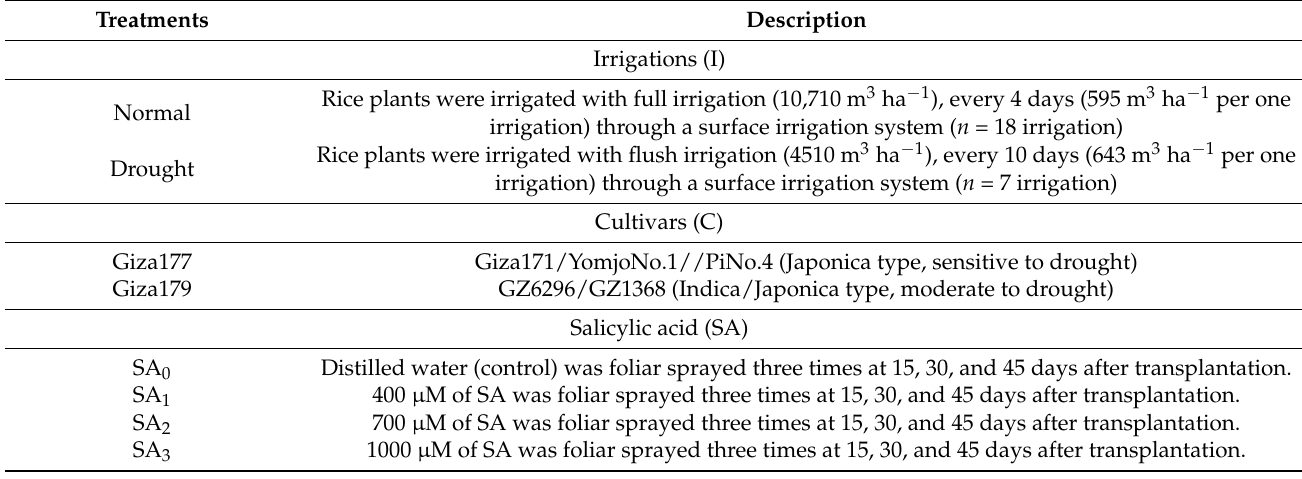
Table 2. Description of irrigation conditions (I), salicylic acid (SA) treatments, and rice cultivars (C) in the studied cultivated